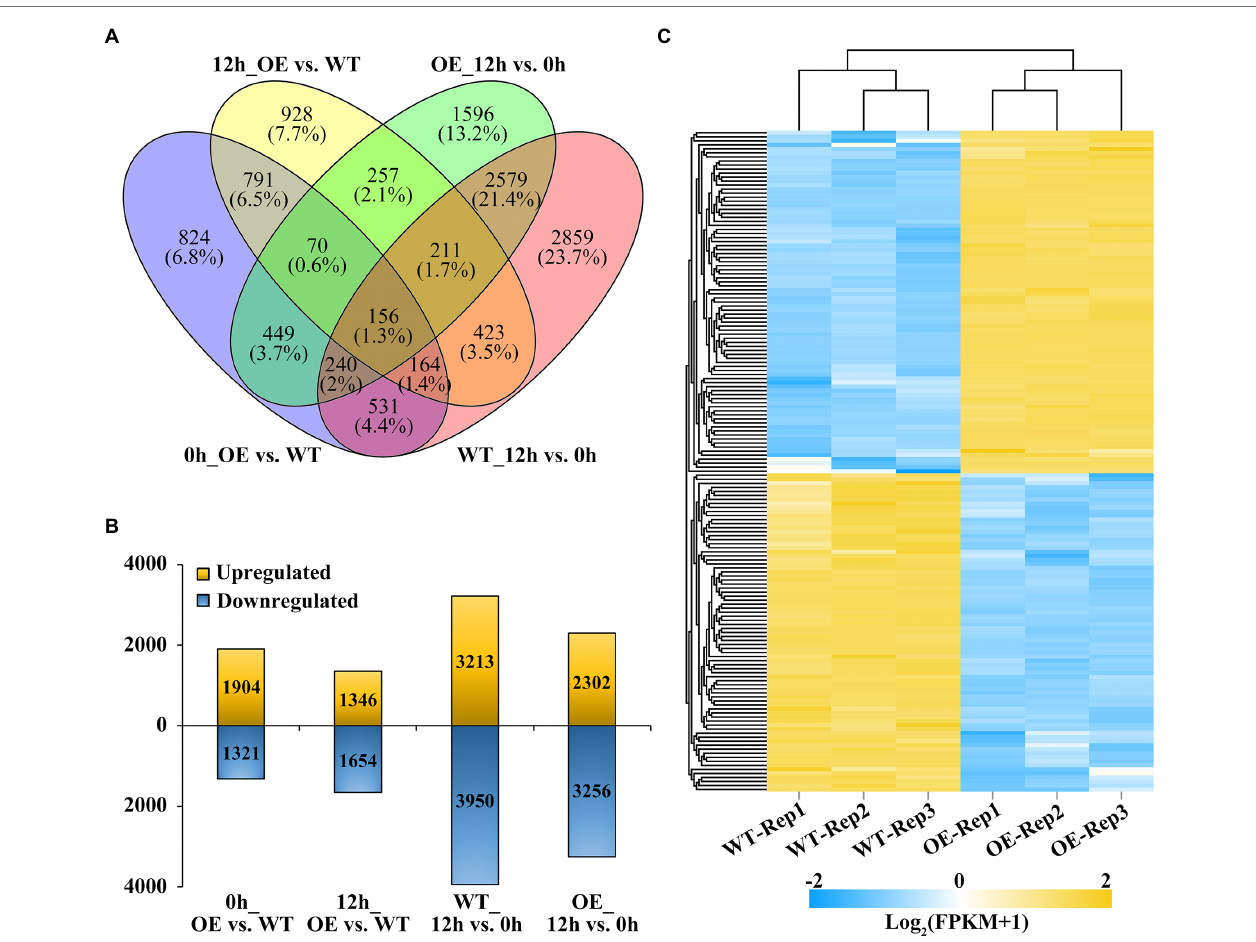
FIGURE 3 | Comparison of significant differentially expression genes (DEGs) identified in BnaMAPK1 -OE and WT rapeseed under shading stress. (A) Venn diagram of DEGs in total by four comparisons of WT with BnaMAPK1 -OE samples at control and shading stress conditions. DEGs screened with FPKM value of three replicates > 1, |Log 2 FC| > 1, and FDR < 0.05 among each pairwise comparisons. (B) Statistics of the number of upregulated and downregulated DEGs in four comparisons of WT with BnaMAPK1 -OE samples at control and shading stress. (C) Expression heatmap of significant DEGs in BnaMAPK1- OE and sWT rapeseed under shading stress. One hundred and sixty four DEGs screened with each FPKM value of three replicates > 1, |Log 2 FC| > 3, and FDR < 0.05. 0h_OE vs. WT, BnaMAPK1 -OE samples with WT at normal light; 12h_OE vs. WT, BnaMAPK1 -OE samples with WT at shading stress; WT_12h vs. 0 h, normal light samples with shading treatment samples in WT; OE_12h vs. 0 h, normal light samples with shading treatment samples in BnaMAPK1 -OE